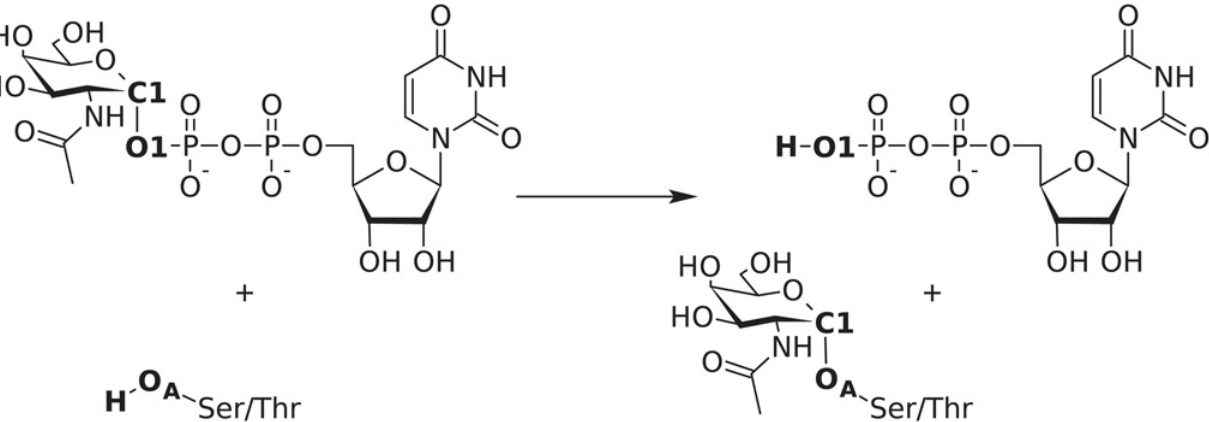
Fig 1. Reaction catalysed by the ppGalNAcT2 glycosyltransferase. The names of atoms used to define PES scan coordinates are set in bold.